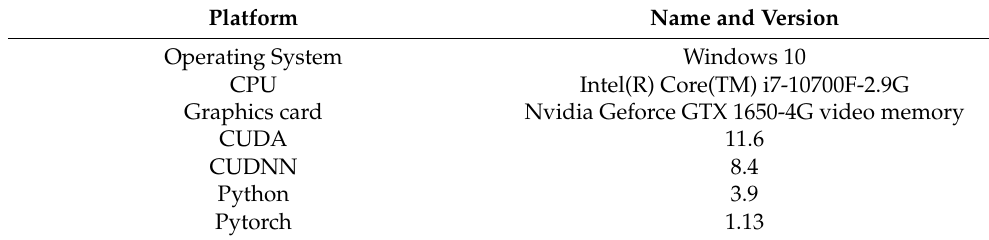
Table 2. Software and hardware platforms.